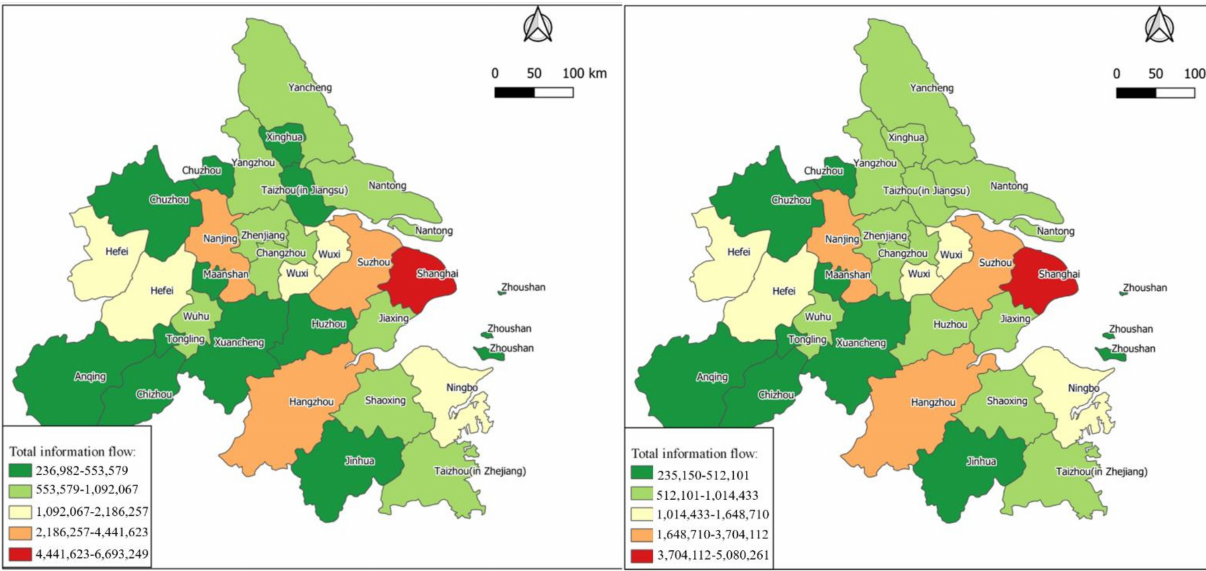
Figure 4. Level of total information